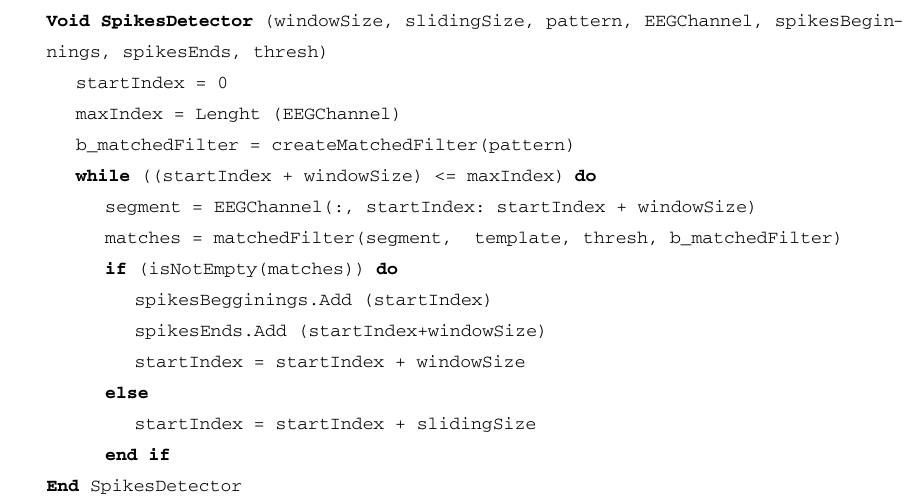
Algorithm 1 . Spikes detector.